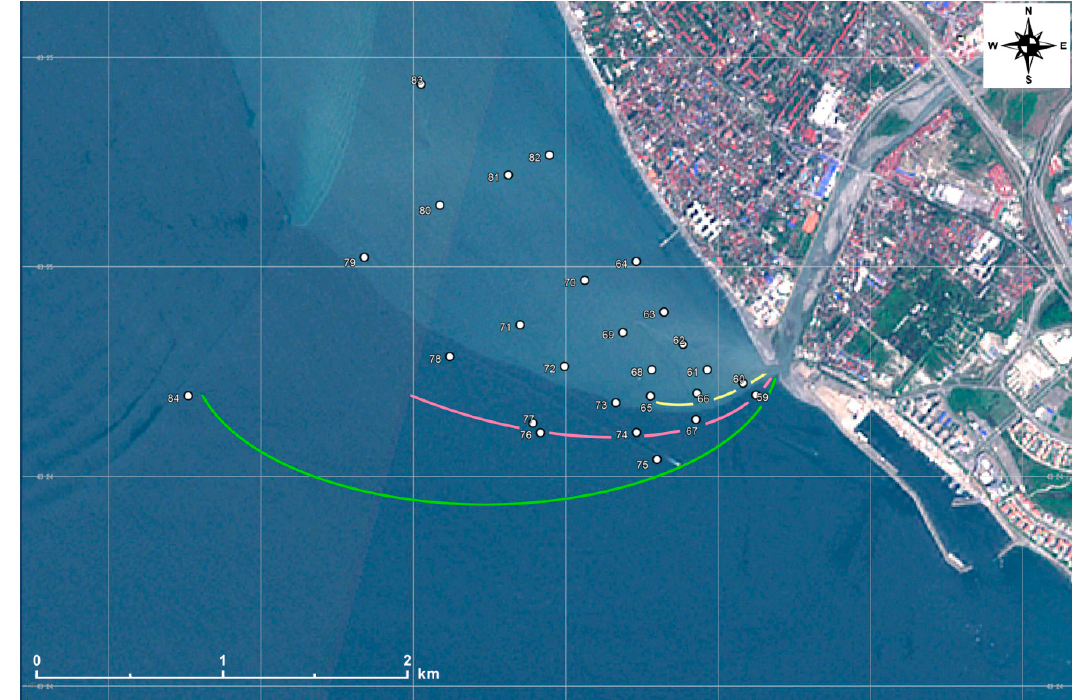
Figure 9. Plume boundary positions on 26 April 2019, at 07:30–08:00 UTC (yellow line); 09:11–09:29 UTC (pink line) and 10:30–11:00 UTC (green line) superimposed on a Sentinel-2B MSI image taken at 08:27 UTC on the same day.